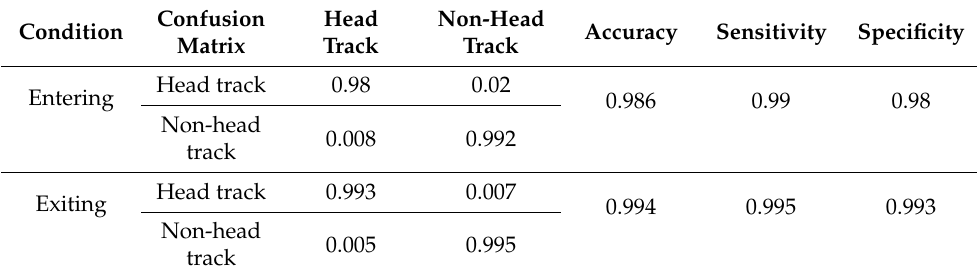
Table 3. Tracking Accuracy achieved over the PCDS